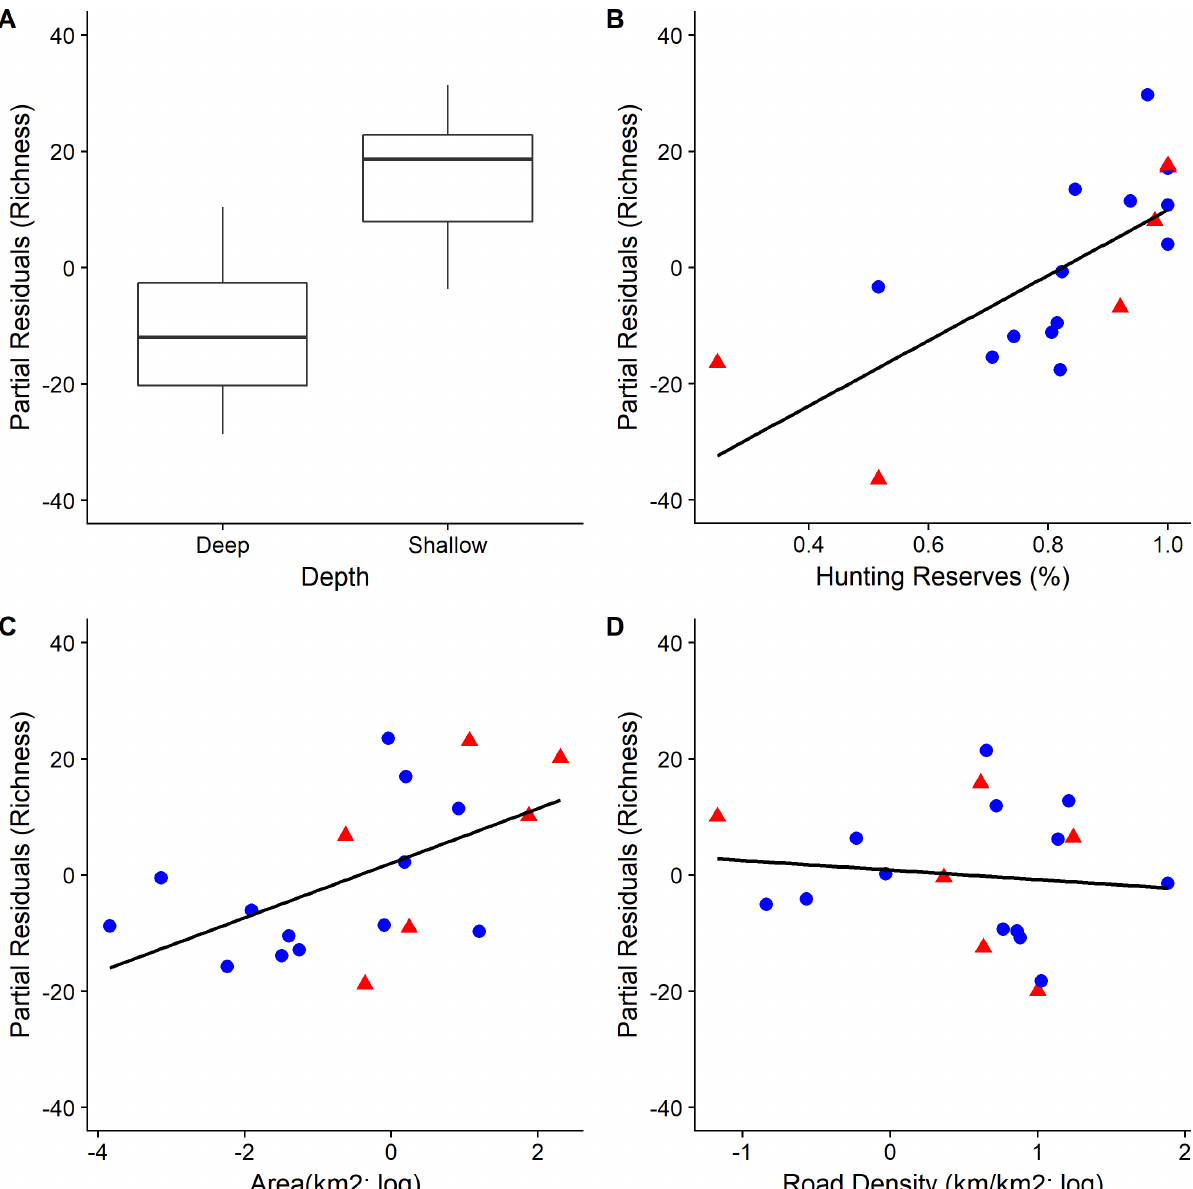
Fig 4. Partial residual plots illustrating the relationship between each of the four explanatory variables and species richness (S) in year 2011. Blue circles ( ● ) correspond to artificial wetlands and red triangles ( ▲ ) to natural wetlands. Boxplots are based on the median and the 1 st and 3 rd